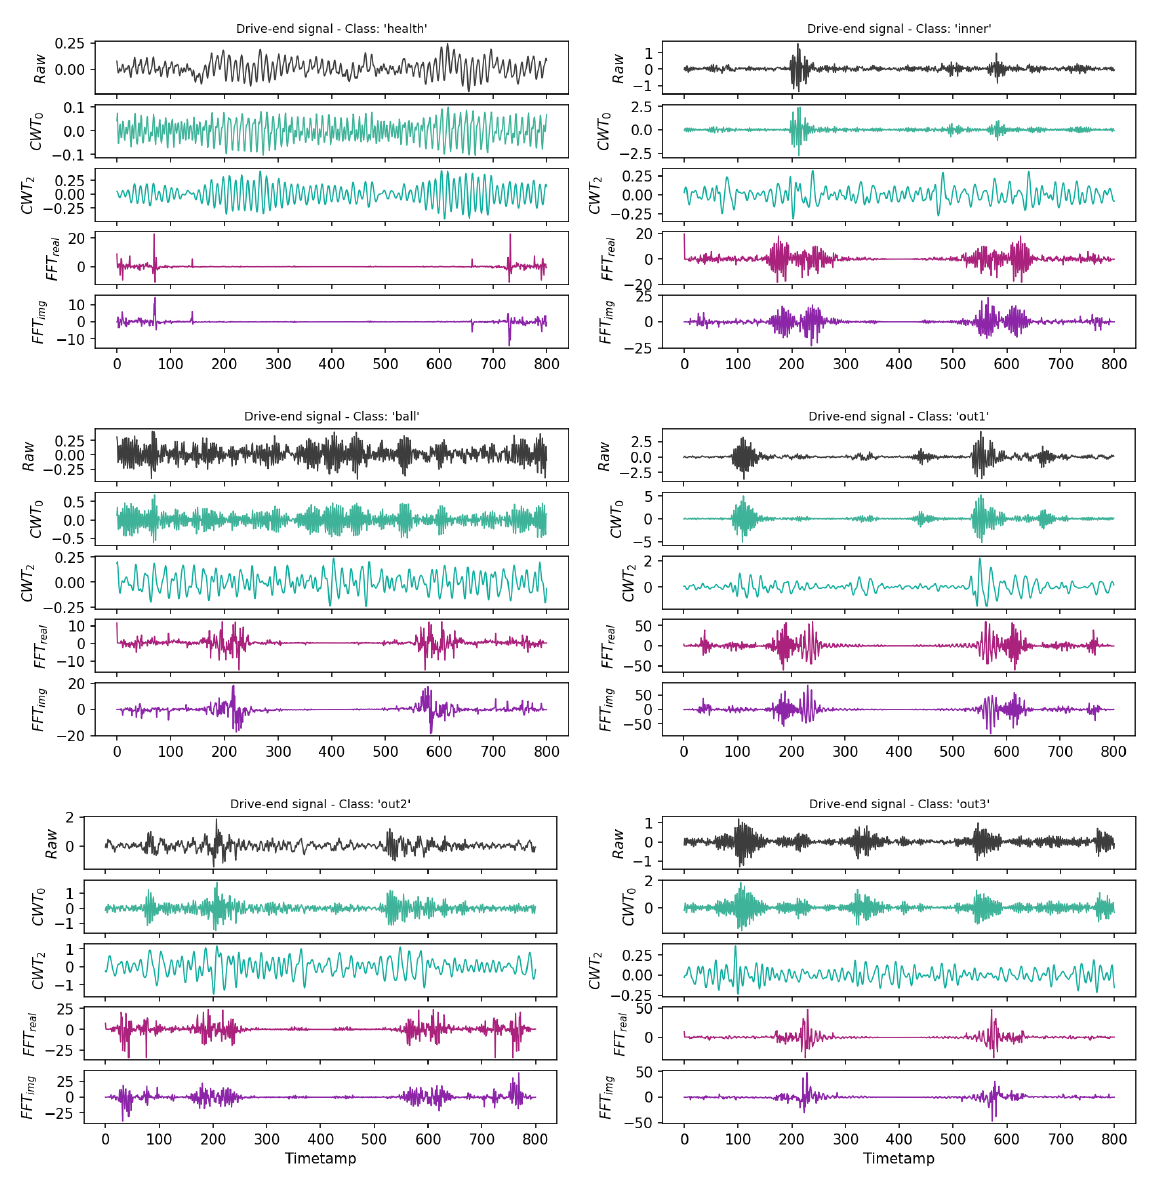
Figure 4. Illustration of the extracted features from some raw